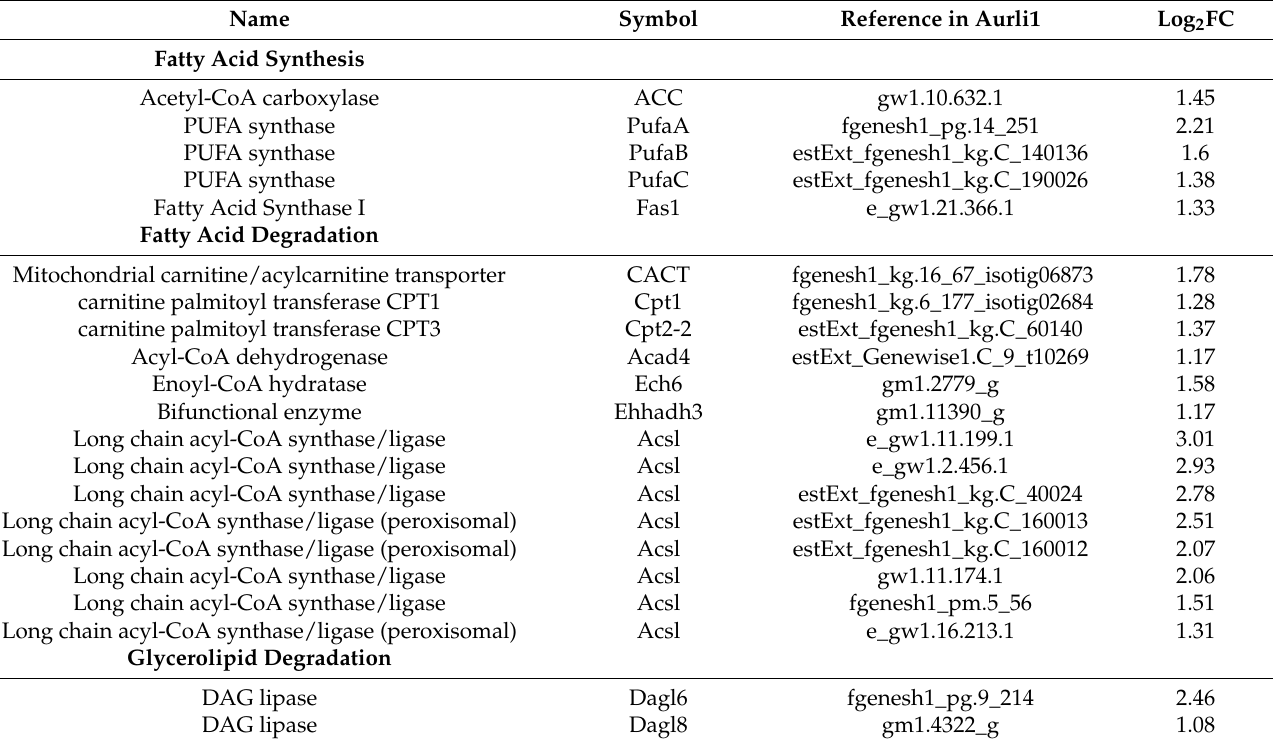
Table 1. Differentially expressed genes involved in FA synthesis and FA degradation (LAS versus WT, log 2 FC > |1|). Genes and predicted functions referred to the Aurli1 database for Aurantiochytrium limacinum ATCC